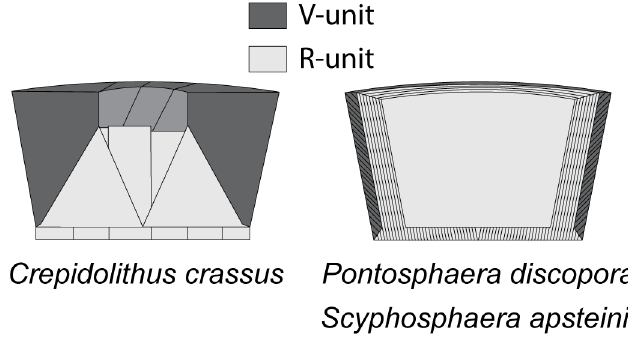
Figure 4. Crystal assembly of Crepidolithus, Pontosphaera and Scyphosphaera . R-units (light grey) and V-units (dark grey), derived from Bown & Young,